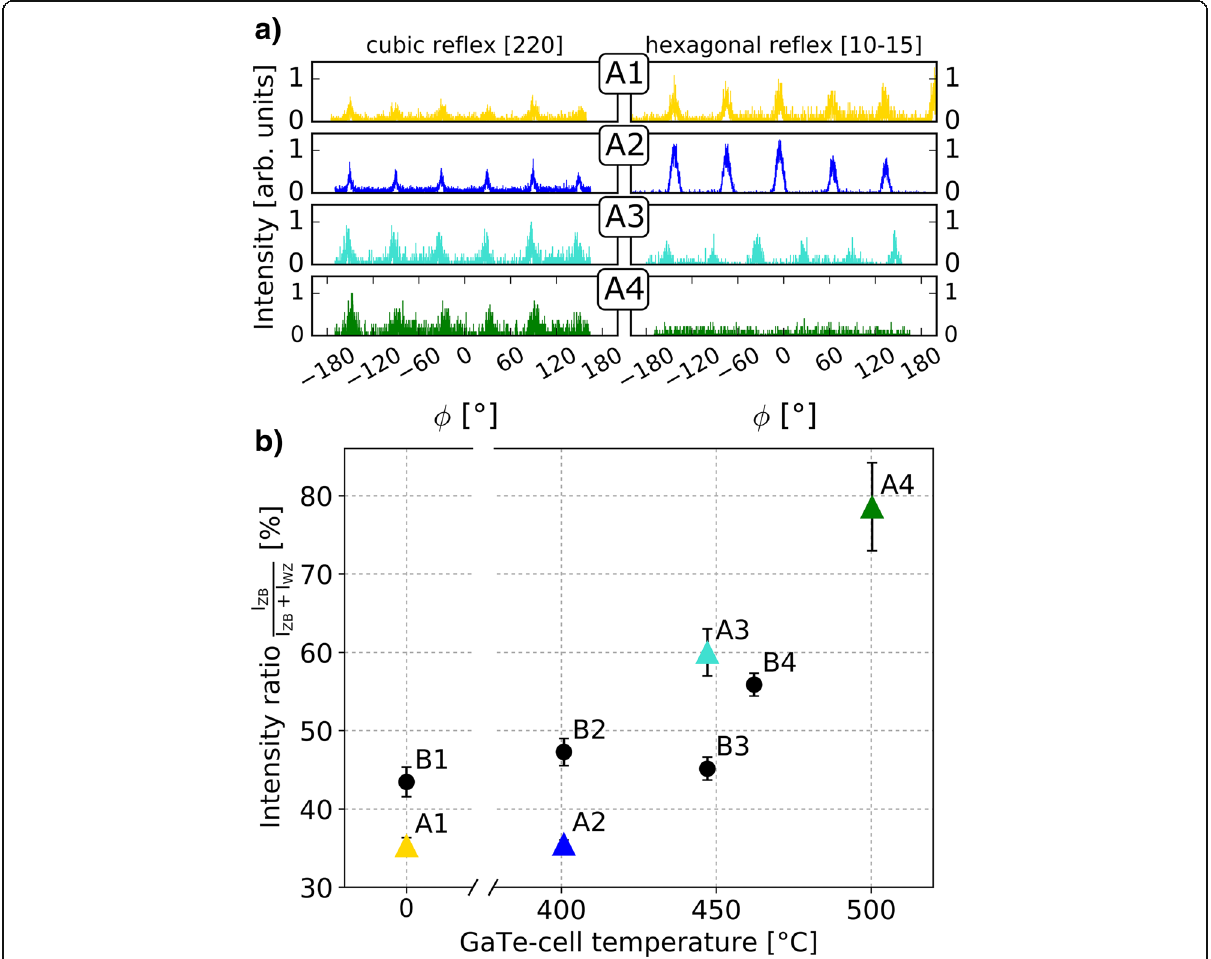
Fig. 5 X-ray analysis of the lattice structure. a φ scans obtained via X-ray measurements on InAs NWs A1-A4. b Resulting I ZB /( I WZ + I ZB ) intensity ratio vs. GaTe-cell temperature. The triangular data points are extracted from the measurements depicted in ( a ) for samples A1 – A4. The black dots indicate the data points of samples B1 –